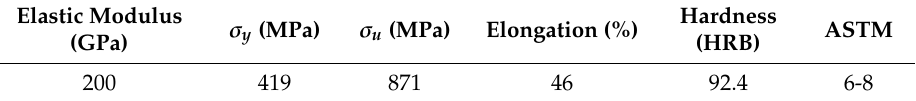
Table 2. Material specifications provided by the material